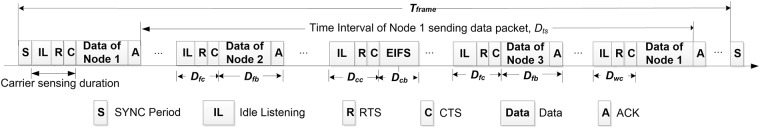
Frame components of SMAC with adaptive listening mechanism.